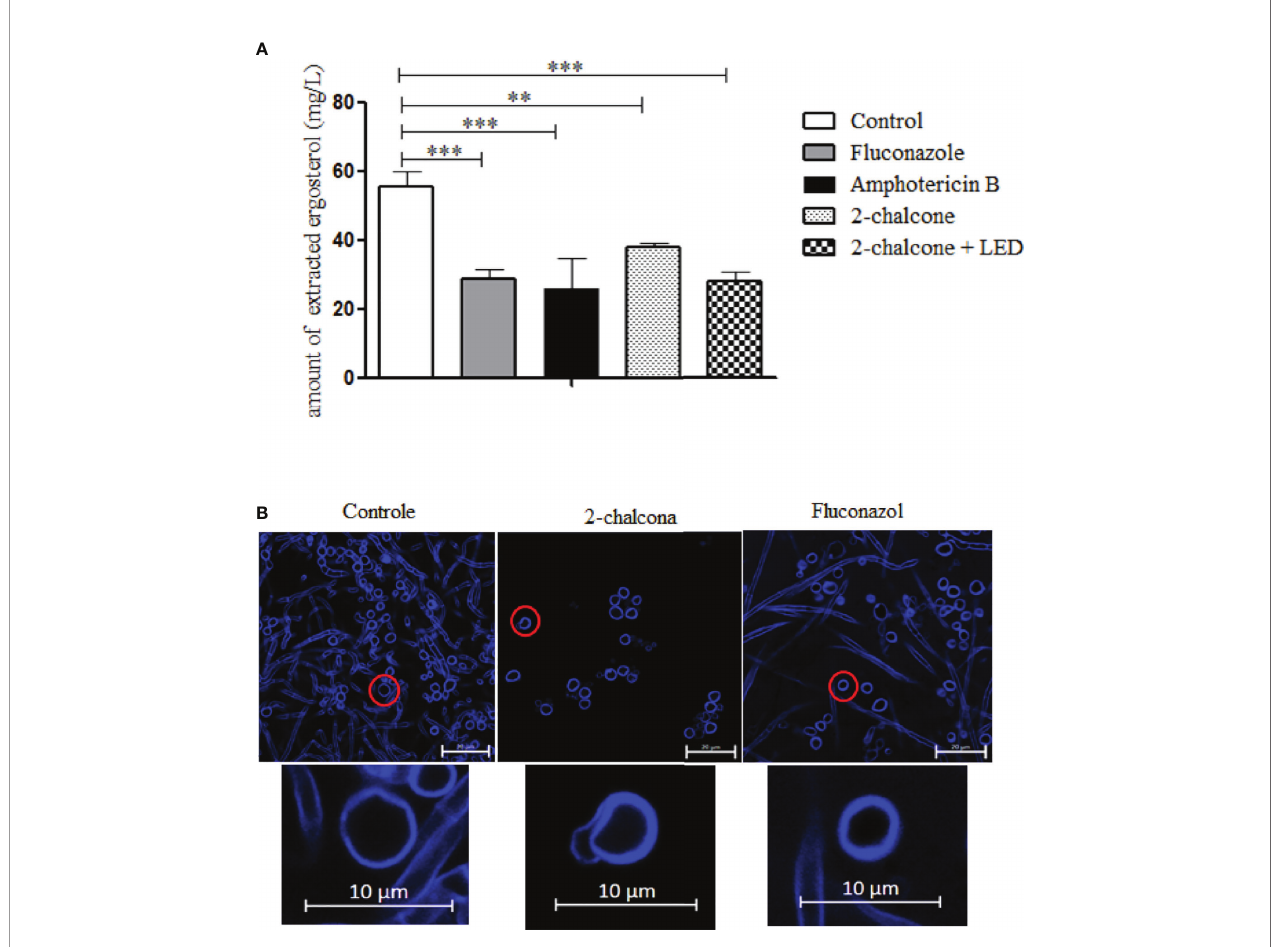
FIGURE 8 | The amount of extracted ergosterol (A) and confocal laser scanning microscopy images (CLSM) (B) of T. rubrum ATCC 28189 treated with 2-chalcone, fl uconazole, and amphotericin B. The ergosterol quanti fi cation graph shows that treatments with 2-chalcone in the dark and 2-chalcone-mediated PDT reduced the amount of sterols extracted, suggesting that this molecule may have an action on ergosterol or its synthesis chain. Amphotericin B and fl uconazole also reduced the amount of steroids extracted, proving their direct action and on the synthesis chain, respectively. In CLSM images, the cell wall is stained with calco fl uor white. Cells treated with 2-chalcone showed changes in the cell wall with compromised structure. However, cells treated with fl uconazole showed cell wall integrity. **p < 0.01; ***p <